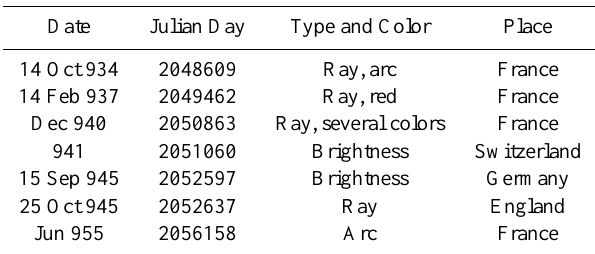
Table 3. Some aurorae during the 10th century described in